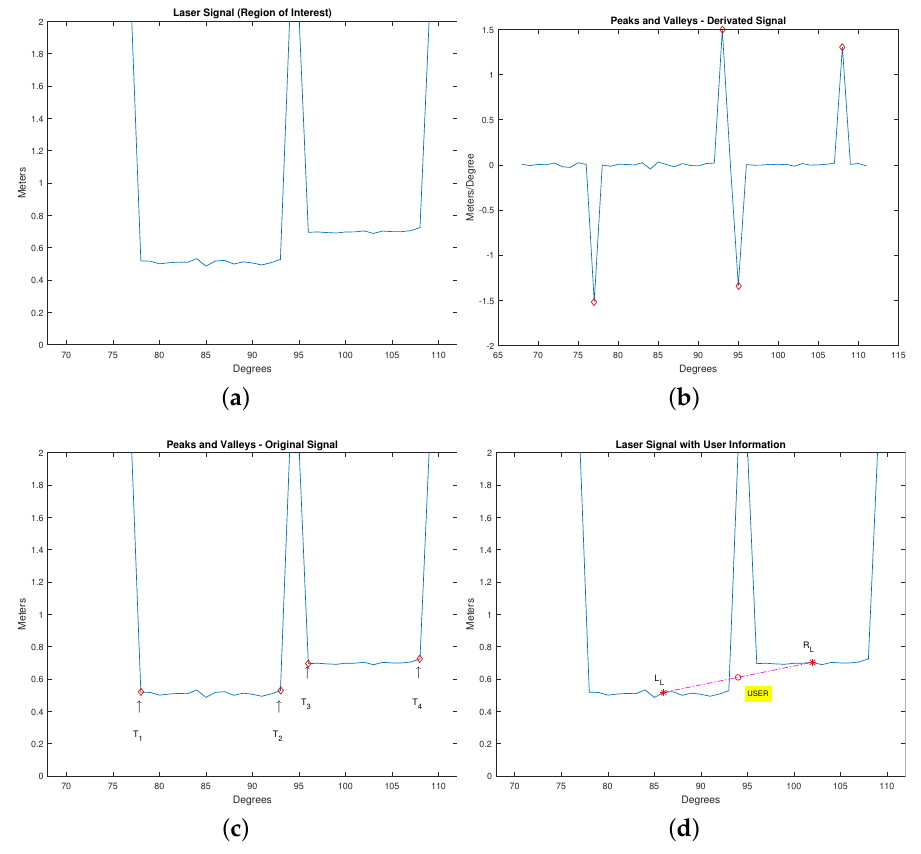
Figure 5. Example of finding the user based on the position of each leg. ( a ) Laser signal inside the region of interest; ( b ) signal derivative and transitions (peaks and valleys); ( c ) transitions in the original signal; ( d ) legs and user